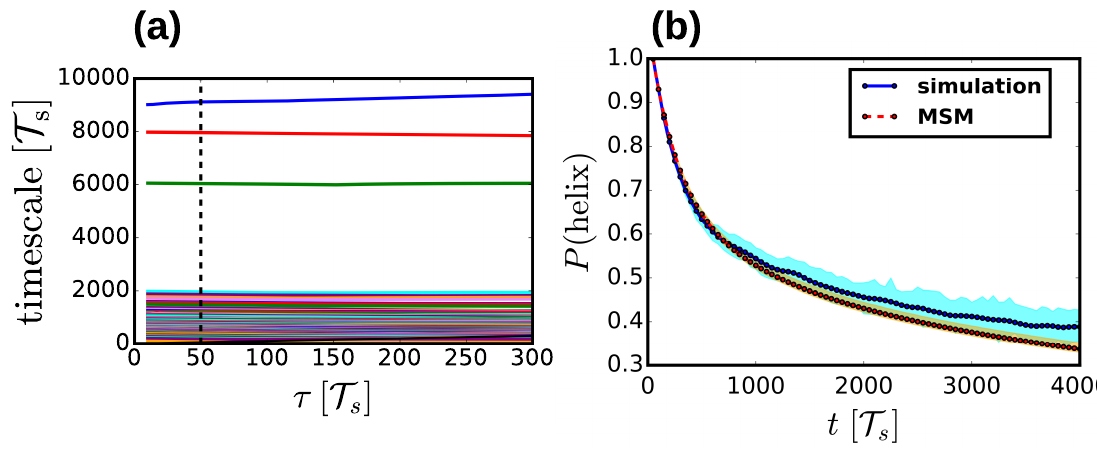
Figure 2. ( a ) Representative implied timescale test. Each line represents a different characteristic timescale of the Markov state model as a function of lag time. The vertical dashed line denotes the lag time chosen in this case. ( b ) Representative Chapman-Kolmogorov test. The “helix” state corresponds to the microstate for each model with the highest helical content (see Methods section for details). The blue solid curve presents the probability decay of the helix state, as determined directly from the simulation trajectory, while the red dashed curve presents the same quantity determined from the MSM. The transparent cyan and orange regions denote the error bars for each